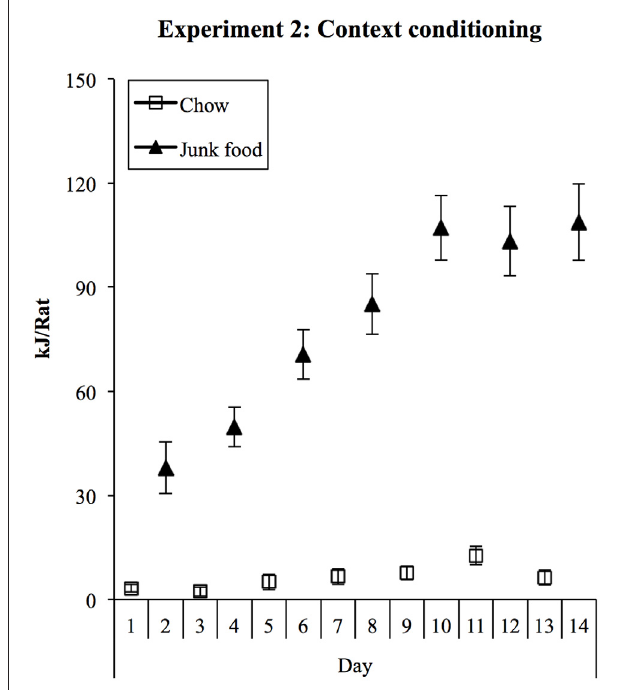
minimal amounts of chow in the chow